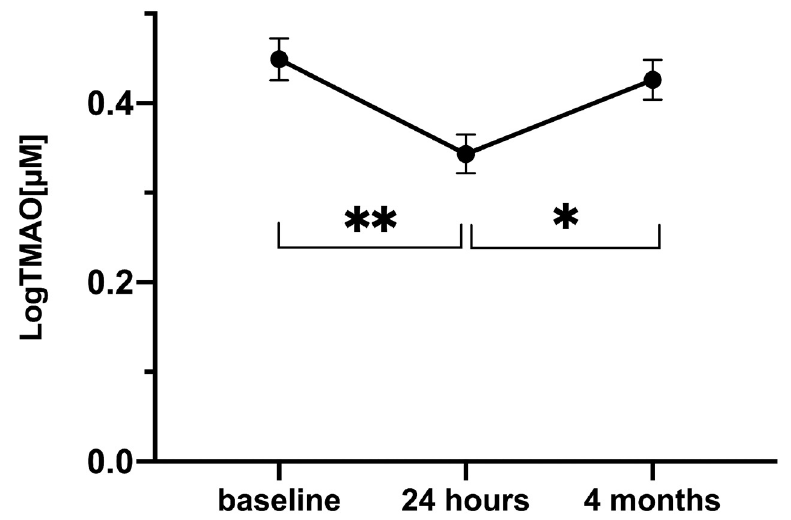
Figure 1. LogTMAO levels across time in subjects admitted via the STEMI protocol ( n = 379). Mixed model analysis was utilized to contrast the temporal course of logTMAO between categorical groups. Data are presented as mean and standard error of the mean (SEM). * = p ≤ 0.05; ** = p ≤ 0.001